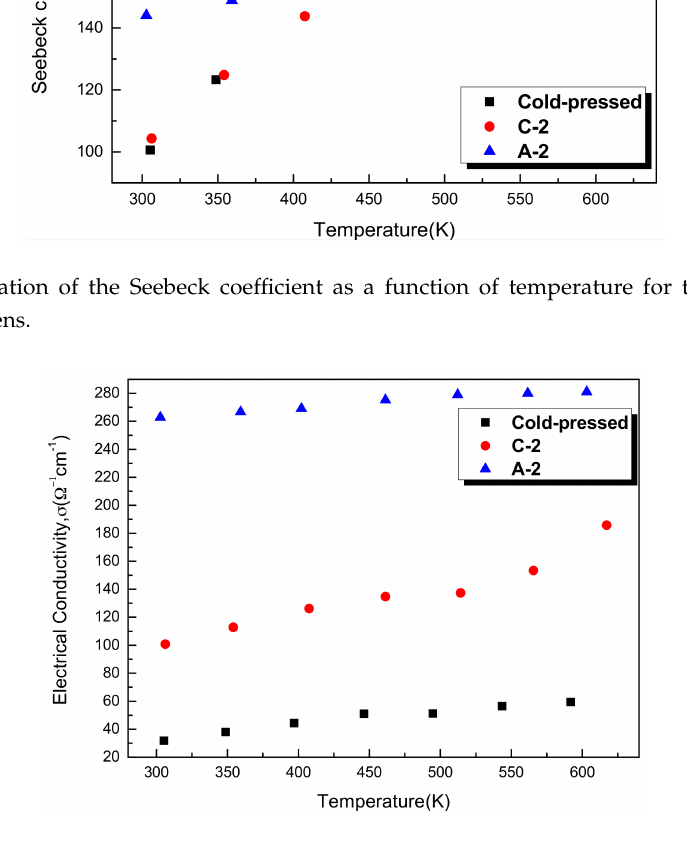
Figure 9. Variation of the electrical conductivity as a function of temperature for the hot pressed Zn 4 Sb 3